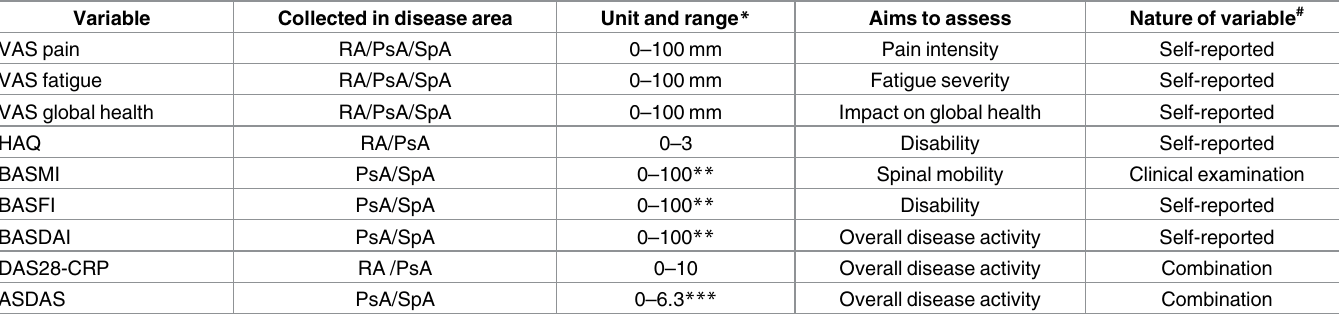
Table 1. Overview of patient reported outcome measuresand disease activity scores available in the DANBIO